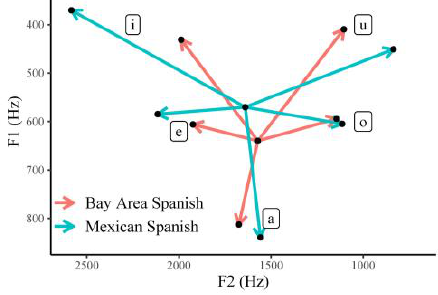
Figure 4. Spanish vowel space dispersion in Bay Area Spanish and Mexican Spanish.